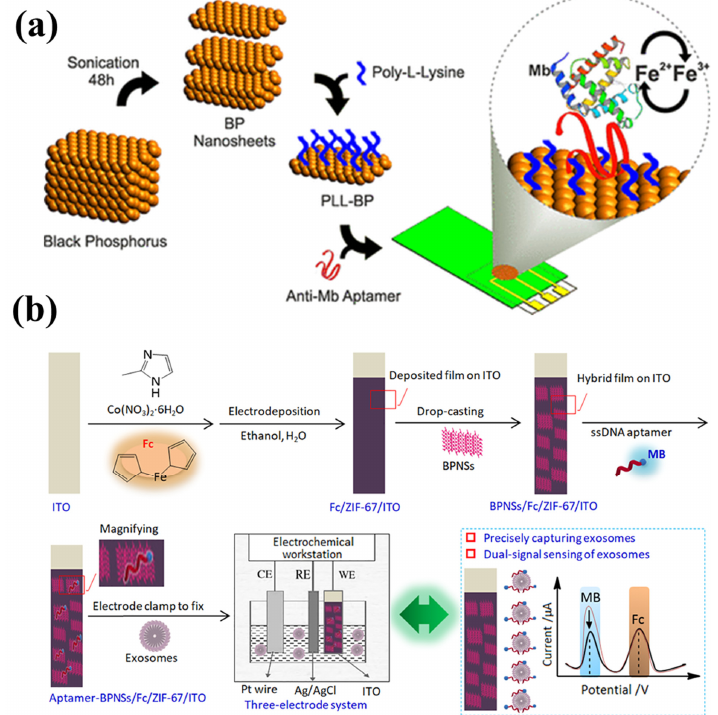
Figure 9. ( a ) An illustration of the steps involved in creating a bio interface on an electrode for Mb detection, including liquid phase exfoliation of BP nanosheets and surface modification of those nanosheets. ( b ) Schematic of fabrication, characterization, and application of the aptasensor of exosomes for dual-signal and intrinsic self-calibration using a functional hybrid thin-film sensing platform aptamer-BPNSs/Fc/ZIF-67/ITO. Reproduced with permission from [88,89].